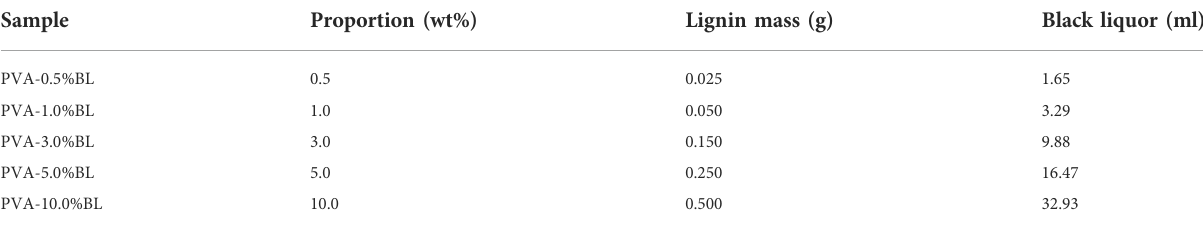
TABLE 1 Preparation parameters of PVA/BL fi lms.